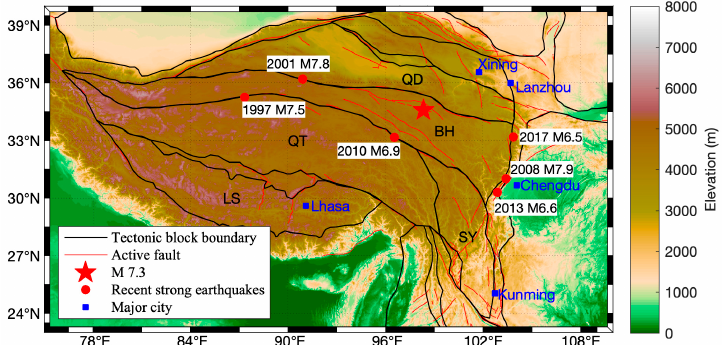
Figure 1. Distribution map of elevation, tectonic blocks in Tibetan Plateau, and the Madoi M 7.3 earthquake on 21 May 2021. The boundaries of active tectonic blocks originate from the work of Zhang et al. [39]. The 2021 Madoi earthquake was the largest one within the Bayan Har tectonic block, although a few major earthquakes have occurred along the boundary of this block over the past three decades. BH—Bayan Har block; QT—Qiangtang block; QD—Qaidam block; LS—Lhasa block; SY—Sichuan–Yunnan